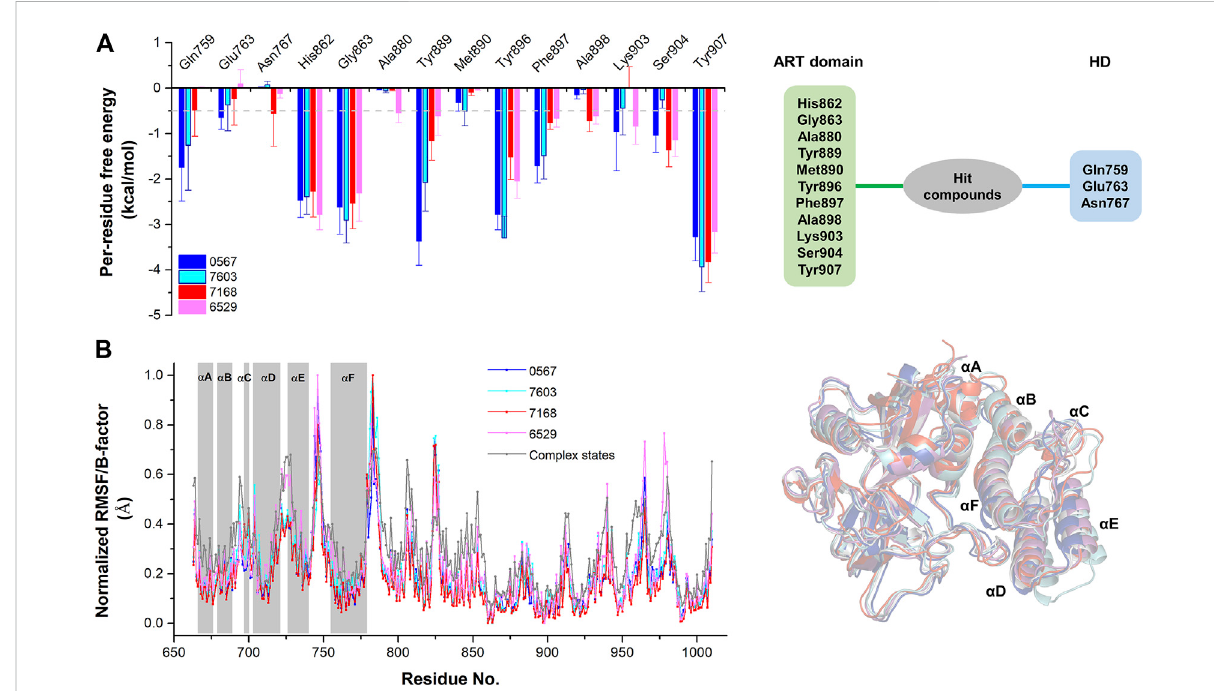
FIGURE 6 Theper-residuefreeenergydecompositionandconformationalanalysisoftheequilibriumconformationsoffourhitcompoundsbymolecular dynamics. (A) The per-residue free energy decomposition of the key residues on ART domain and HD. (B) The normalized RMSF analysis of the equilibrium conformations of four hit compounds compared to the average B-factors of the complex states. The equilibrium conformations of four hit compounds were superposed with the crystal structures (PDB ID: